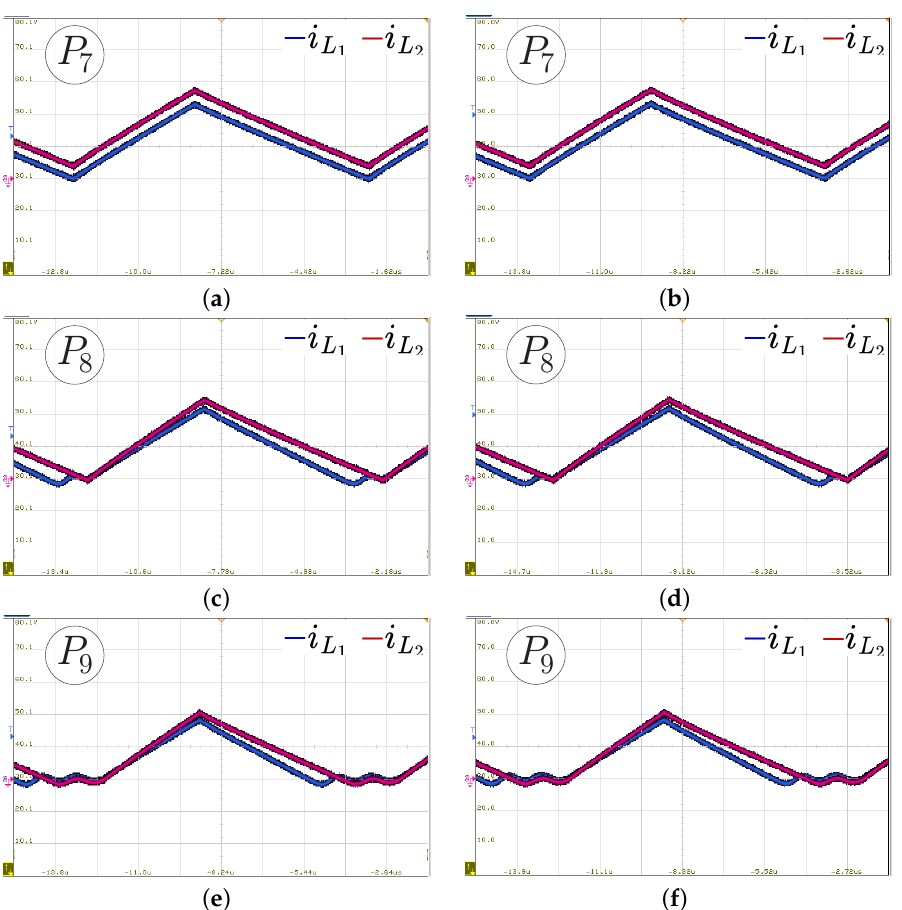
Figure 16. Inductor current waveforms in the closed-loop control with a voltage conversion ratio of 0.7: ( a ) SEPIC in point P 7 , ( b ) ´Cuk in point P 7 , ( c ) SEPIC in point P 8 , ( d ) ´Cuk in point P 8 , ( e ) SEPIC in point P 9 , and ( f ) ´Cuk in point P 9 , (400 mA/div, DC coupling, and a time base of 1.4 µ